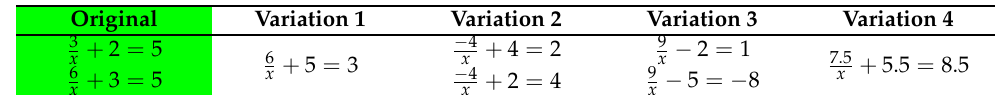
Table 10. Examples of type 9 equations and